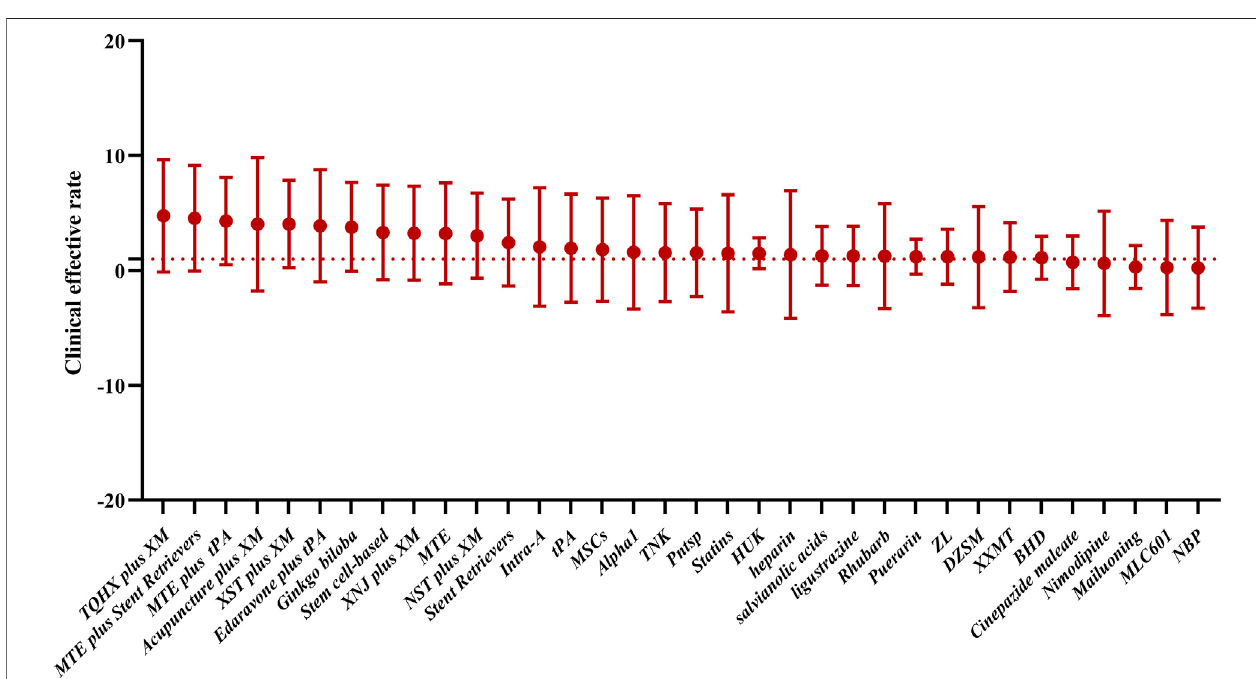
FIGURE 2 | Total clinical ef fi cacy was used to evaluate the effect of drug therapy on ischemic stroke. In this study, the possible order of ef fi cacy of the drugs was TQHXplusXM,MTEplusstentretrievers,MTEplustPA,acupunctureplusXM,XSTplusXM,edaravoneplustPA,Ginkgobiloba,stemcell-basedtherapy,XNJplusXM, MTE, NST plus XM, stent retrievers, intra-A, tPA, MSCs, Alpha1, TNK, Pntsp, statins, HUK, heparin, salvianolic acids, ligustrazine, rhubarb, puerarin, ZL, DZSM, XXMT, BHD, cinepazide maleate, nimodipine, Mailuoning, MLC601, and NBP.